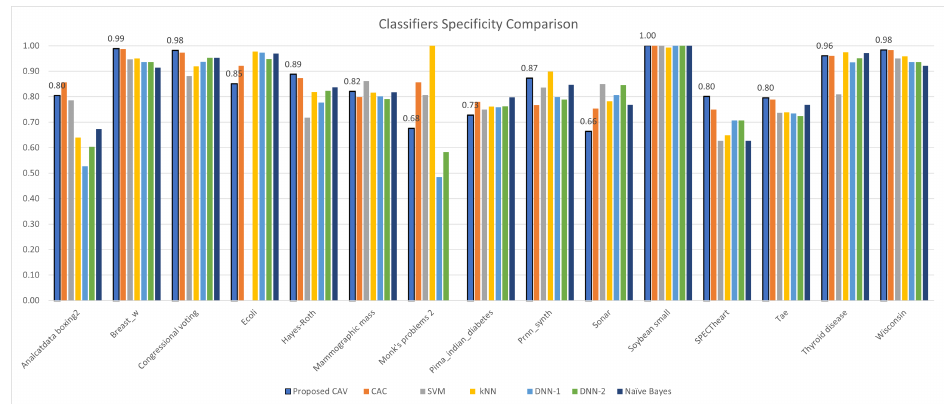
Figure 12. CAV with other classifiers; specificity comparison for the test datasets.